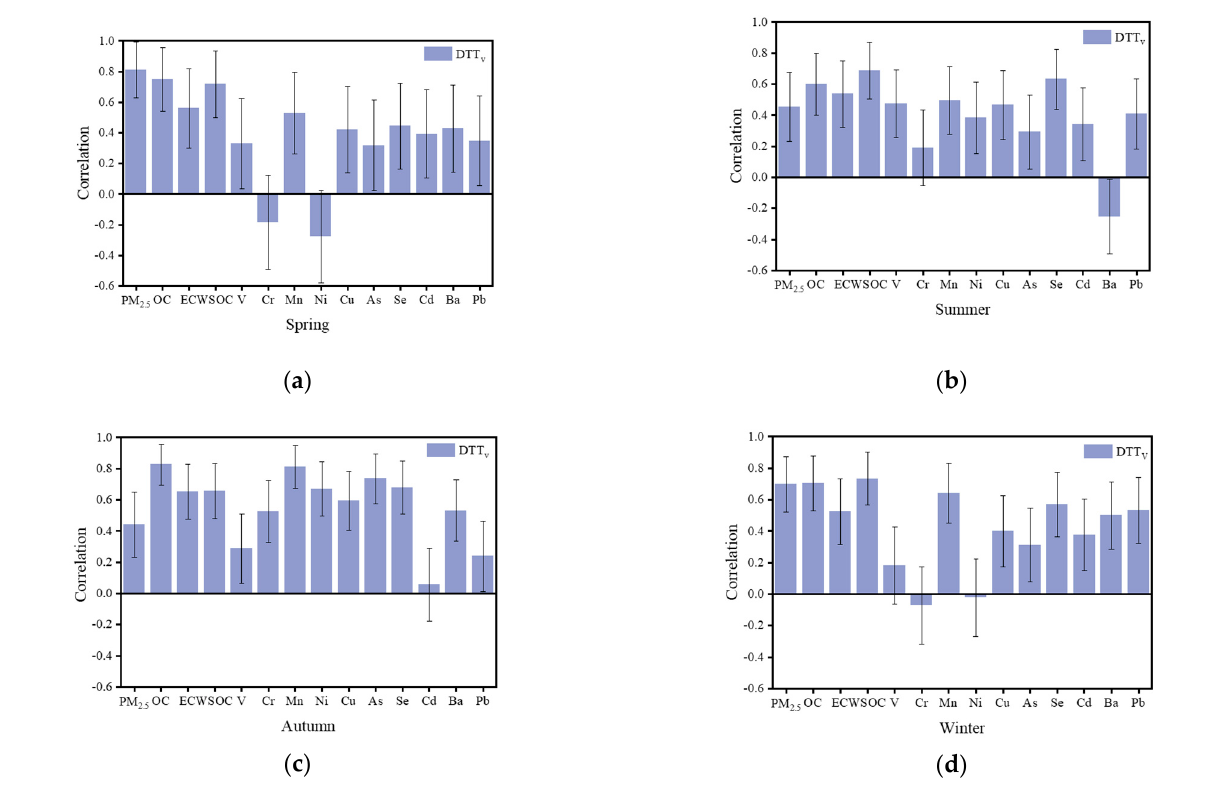
Figure 6. Correlations between DTT v with OC, EC, WSOC, metals, and PM 2.5 mass concentrations in spring ( a ), summer ( b ), autumn ( c ), and winter ( d ).